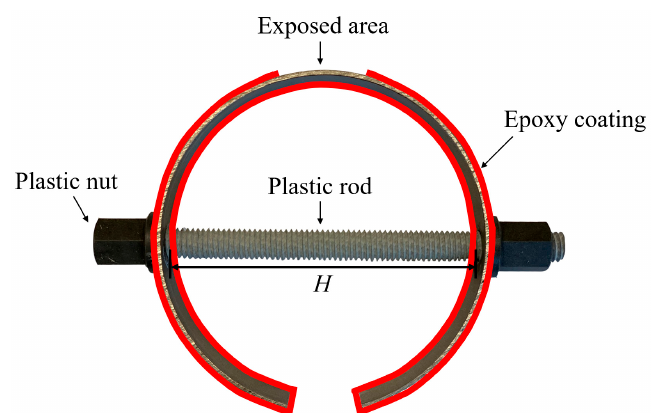
Figure 1. Schematic illustration of the C-shape carbon steel. Table 1. Displacements for the length of the rod ( H ) and the corresponding stress levels. Specimens Nos.